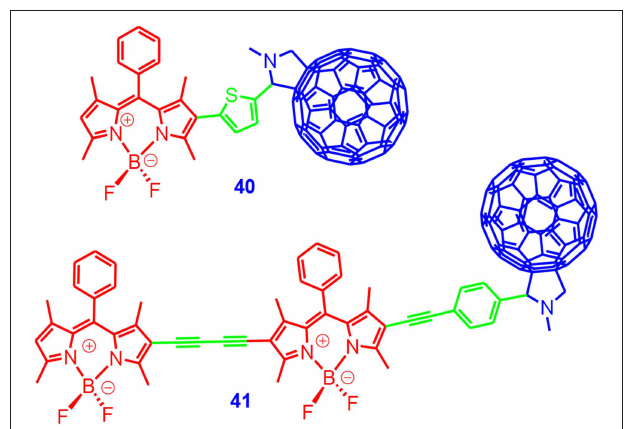
FIGURE 14 | Bodipy–C 60 dyads 40 and 41 as triplet